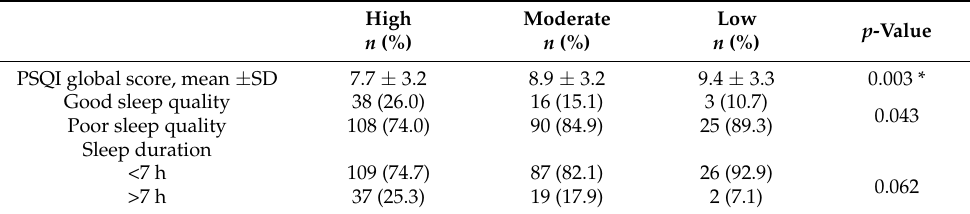
Table 2. Physical activity level and quality of